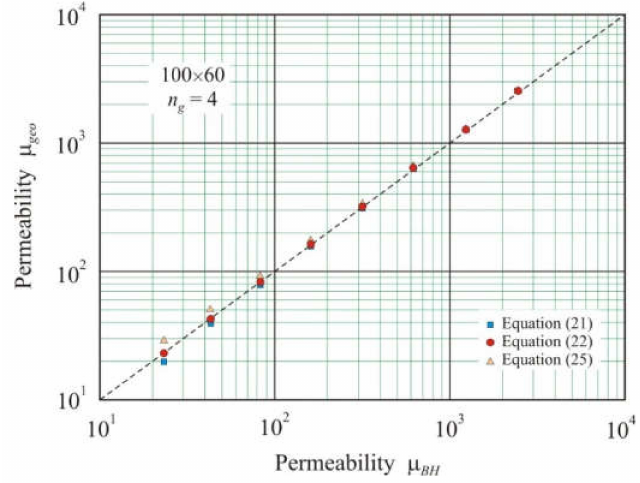
Figure 3. Relationship between geometric permeability µ geo calculated by Equations (21), (22), and (25) and effective permeability µ BH obtained using FEMM simulation in soft magnetic annuluses 100 × 60 mm with four air gaps and total length l g from 1 × 10 − 4 to 1.28 × 10 − 2 m. The dashed line corresponds to equation µ geo = µ BH .